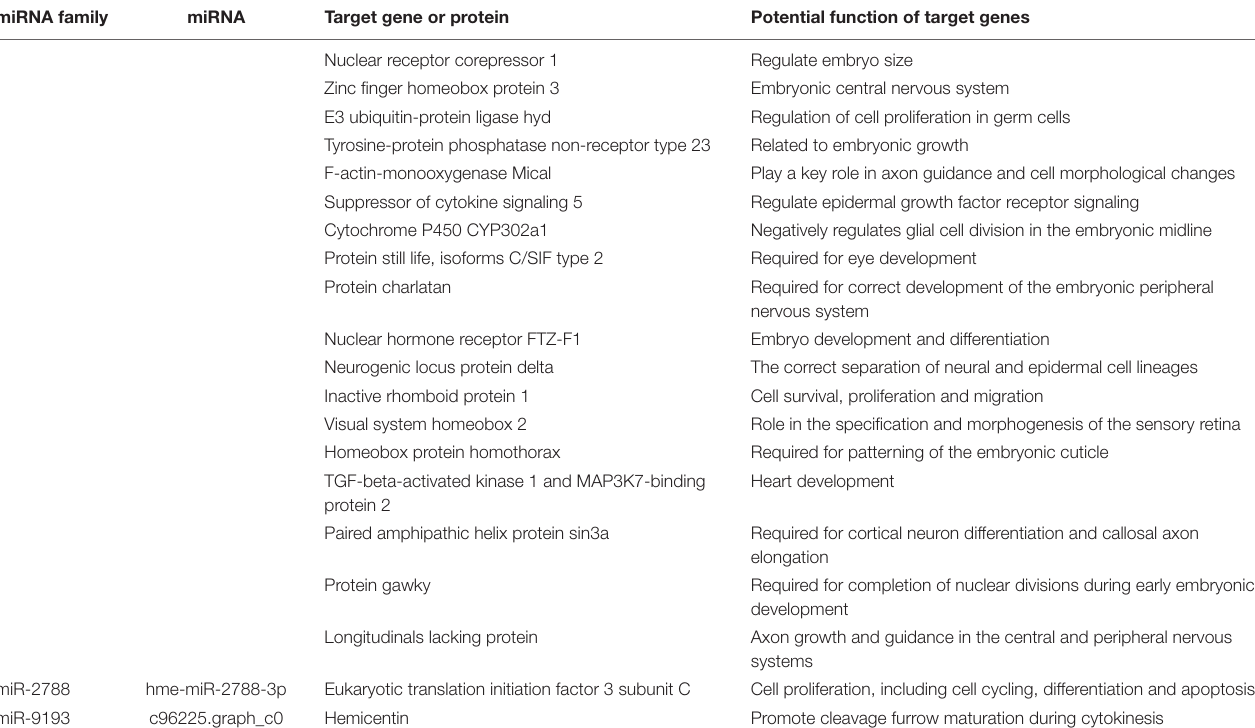
Promote cleavage furrow maturation during cytokinesis